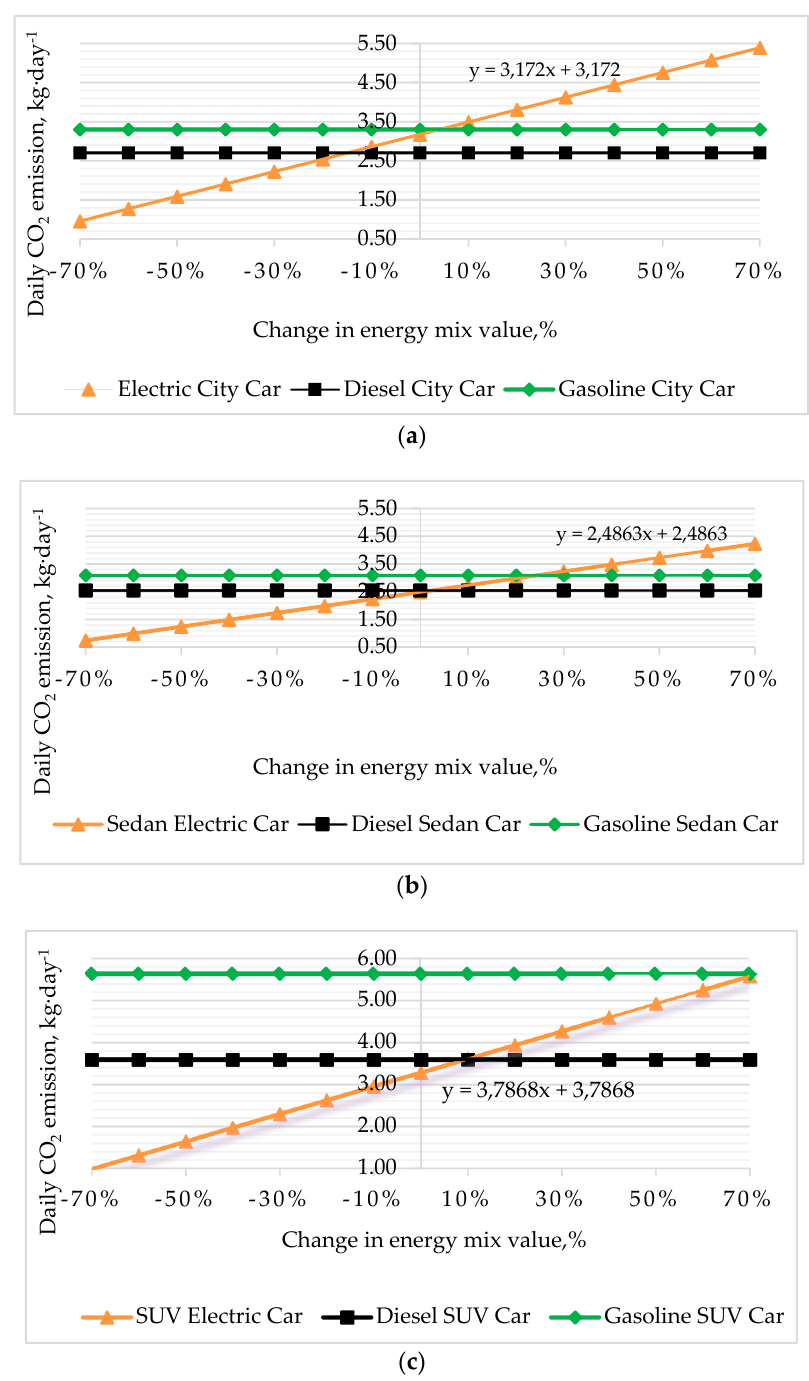
Figure 7. Comparison of direct and indirect emissions of carbon dioxide into the atmosphere when the energy mix value changes: ( a ) city, ( b ) sedan, ( c ) SUV.